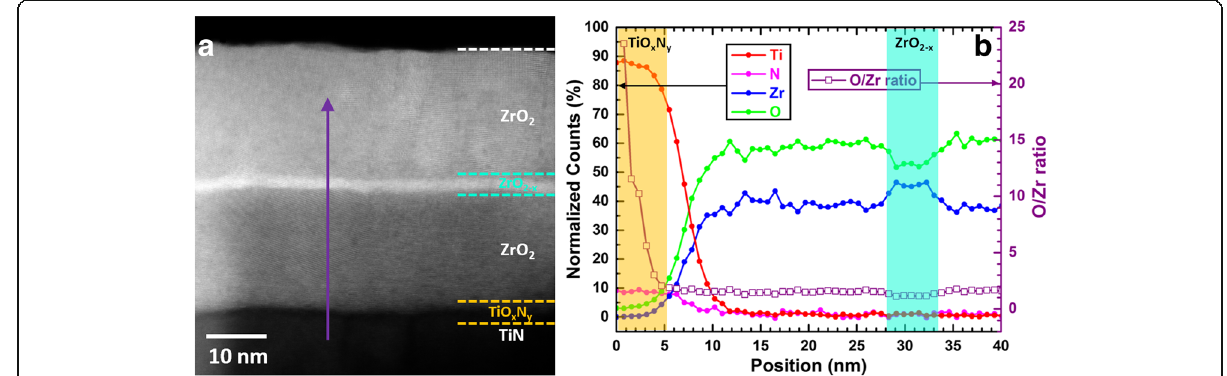
Fig. 3 a ADF-STEM image of the cross section of the sample and b STEM-EDX elemental line profiles of the TiN/ZrO 2 /ZrO 2 − x /ZrO 2 structure